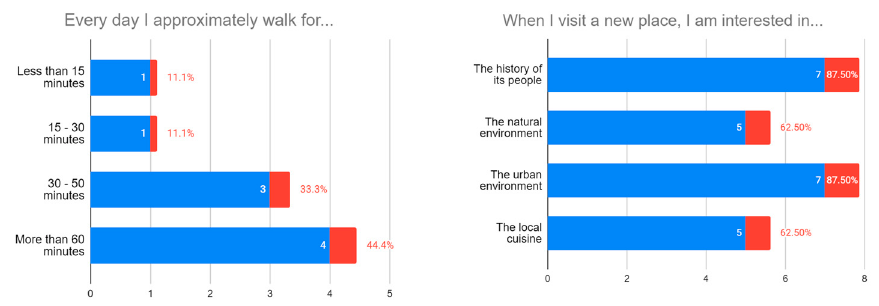
Figure 4. Participants walking habits ( left ) and interests when visiting a new location ( right ).